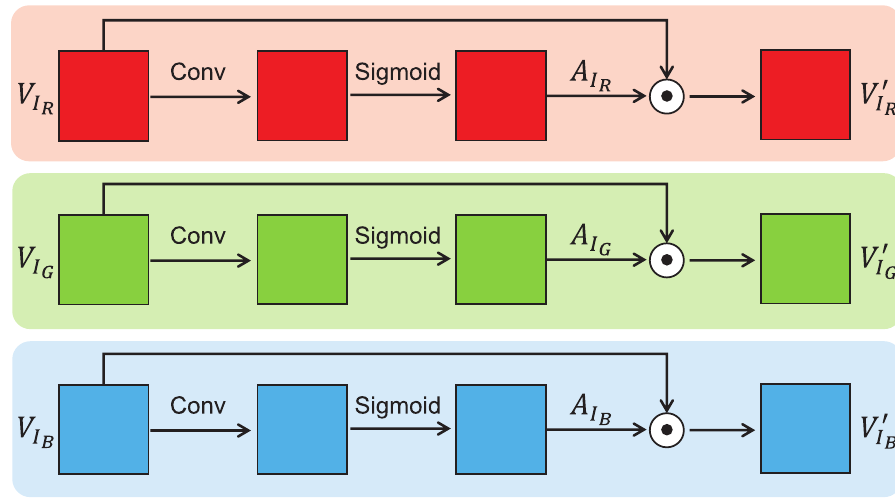
Fig 4. The flow chart of attention